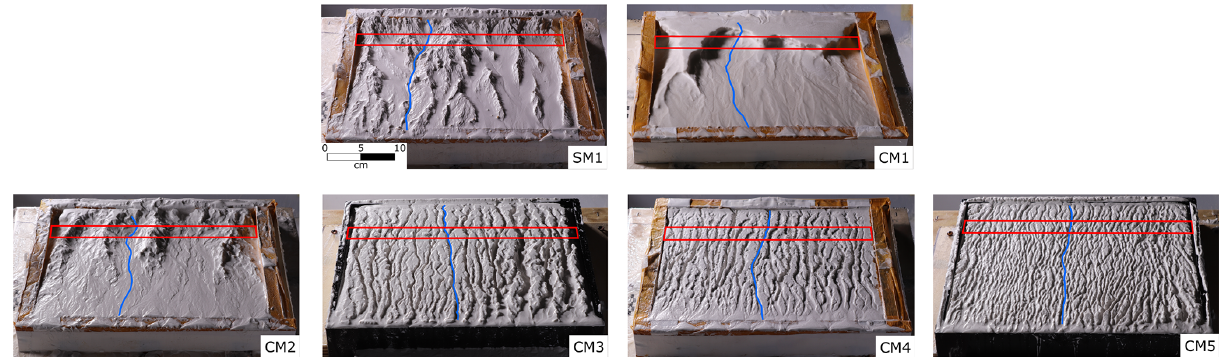
Figure 5. Pictures of the models at 200min from the beginning of the experiment. The red box is the trace of the swath profiles shown in Fig. 6. The blue line indicates the stream for every experiment analyzed in Fig. 7.